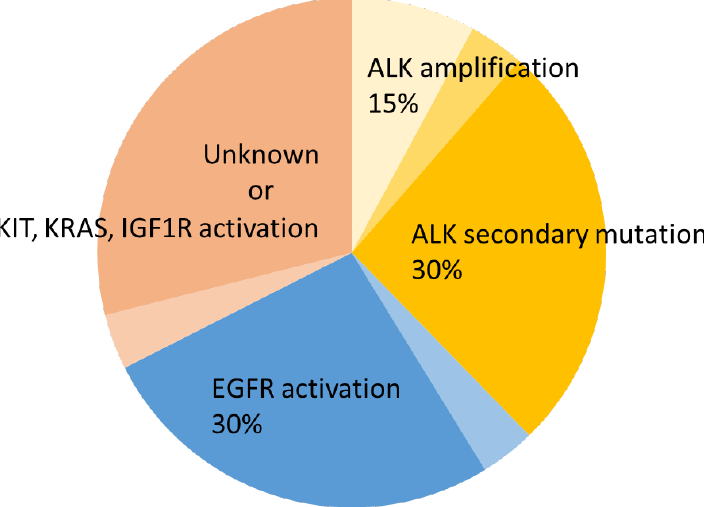
Figure 2. Approximate proportion of crizotinib-resistant mechanisms [32,34]. ALK secondary mutations include 1151Tins, L1152R, C1156Y, F1174L, L1196M, G1202R, S1206Y, and